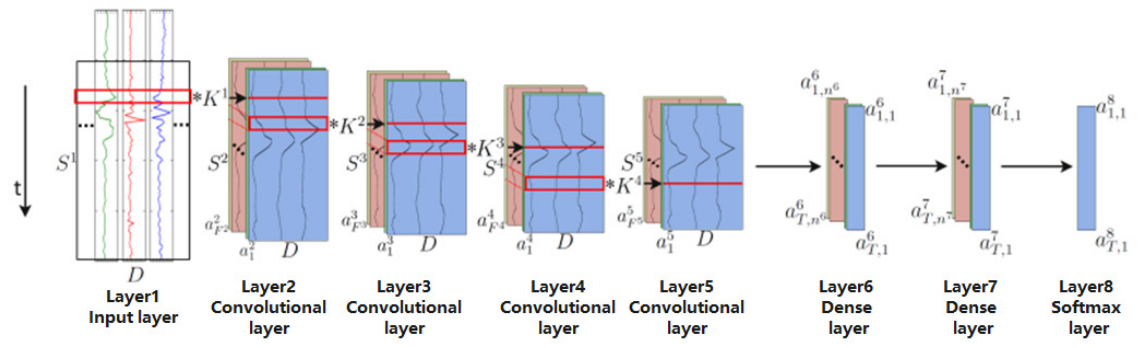
Figure 11. One-dimensional convolution and recursive feature extraction algorithms.